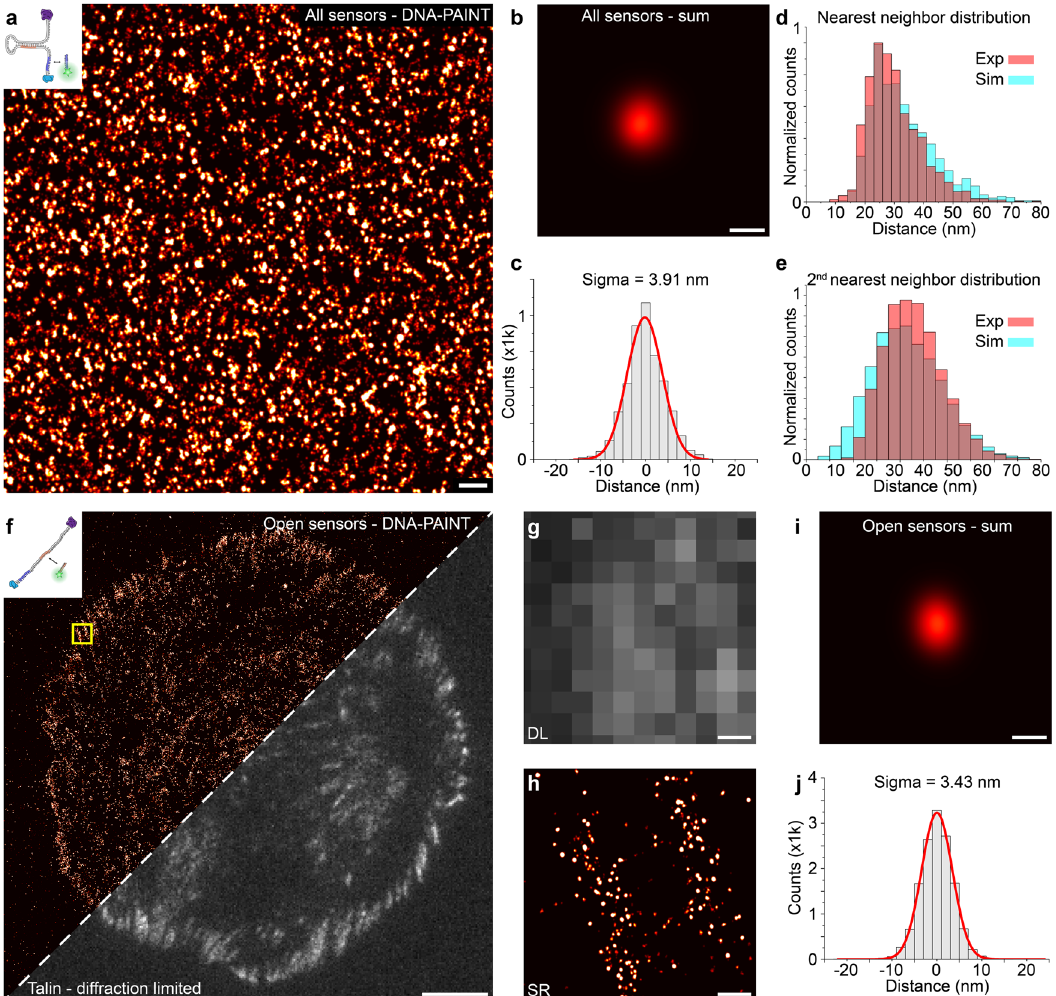
Fig. 2 DNA-PAINT imaging of surface-immobilized and mechanically unfolded sensors. a Super-resolved overview image of surface-immobilized, closed hairpin sensors (targeting of blue docking sequence). b Center-of-mass-aligned sum image of 100 single sensor signals. c Cross-sectional histogram yields localization precisions of 3.91 nm. d Experimentally determined Nearest Neighbor Distance (NND) distribution of the single sensor sites (red) and simulated NND distribution assuming Complete Spatial Randomness (CSR) at the same surface density of 422 molecules per µ m 2 (cyan) con fi rms random distribution of DNA hairpin sensors on the surface. e Experimental 2 nd nearest neighbor distance distribution (red) and corresponding random distribution with the same molecular density (cyan). f DNA-PAINT super-resolved image of extended DNA hairpin sensors (targeting the orange sequence) 25 min after seeding of fi broblasts on the hairpin-functionalized cover slip (left). Corresponding diffraction-limited talin signal (right) highlights localization of extended hairpin sensors to focal adhesion sites. g Zoom-in of highlighted area in f of the diffraction-limited talin signal. h Corresponding zoom-in of the super-resolved extended hairpin sensors. i Center-of-mass-aligned sum image of 100 single extended sensor signals. j Cross-sectional histogram yields localization precisions of 3.43 nm, highlighting that indeed single hairpins (and thus engaged cRGD ligands) are visualized. Scale bars: 100 nm ( a ), 10 nm ( b, i ), 5 µ m ( f ), 200 nm ( g , h